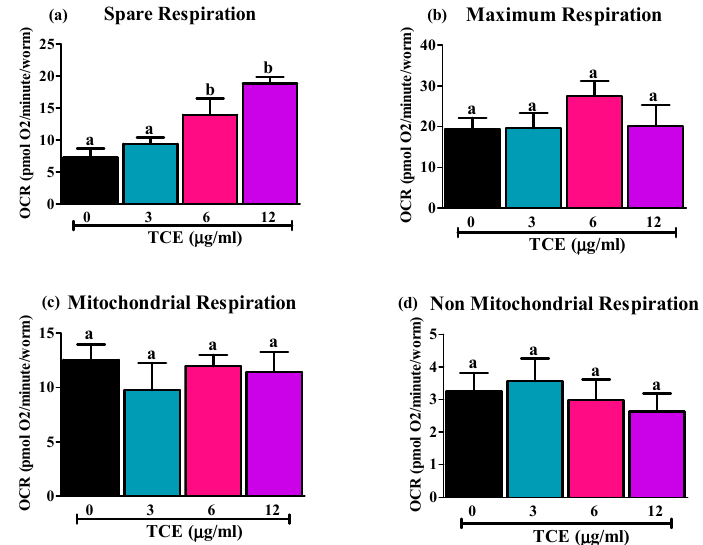
Figure 3. E ff ects of tart cherry extracts (TCE) on respiration capacity in C. elegans . WT worms were Figure 3. Effects of tart cherry extracts (TCE) on respiration capacity in C. elegans. WT worms were treated with 0, 3, 6, and 12 µ g / mL TCE. Sea-horse analysis was used to measure how they utilize oxygen. treated with 0, 3, 6, and 12 μ g/ml TCE. Sea-horse analysis was used to measure how they utilize ( a ) Spare respiration was significantly higher (di ff erent letters (a, b) are significantly di ff erent, p < 0.05, oxygen. (a) Spare respiration was significantly higher (different letters (a, b) are significantly different, one-way ANOVA, 20 worms / well in 4 replicates, n = 3 independent experiments) in 6 and 12 µ g / mL p < 0.05, one-way ANOVA, 20 worms/well in 4 replicates, n = 3 independent experiments) in 6 and 12 TCE treated worms compared to 0 and 3 µ g / mL treated worms. No di ff erence was observed in ( b ) μ g/ml TCE treated worms compared to 0 and 3 μ g/ml treated worms. No difference was observed in maximum respiration, ( c ) non-mitochondrial, or ( d ) mitochondrial respiration in TCE treated worms (b) maximum respiration, (c) non-mitochondrial, or (d) mitochondrial respiration in TCE treated compared to non-treated worms compared to non-treated worms.